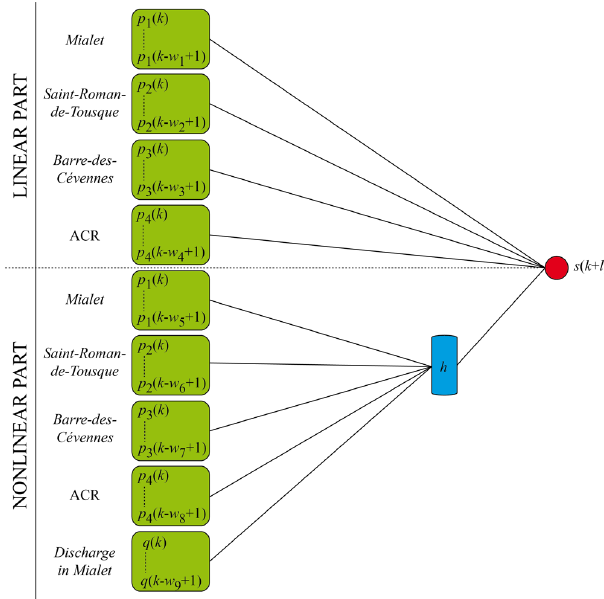
Fig. 6. Feedforward model. Green elements are rain gauge input variables or discharge in Mialet (noted q) , blue element represents hidden layer and red circle represent the linear output neuron. ACR represents the average cumulative rainfall; p n refers to the rainfall (instantaneous or cumulative) value and w i to the length of the re- spective sliding window. l is the forecast lead time. The sliding win- dow of previous estimated discharges is r : the order of the model. The number of neurons on the hidden layer is h .